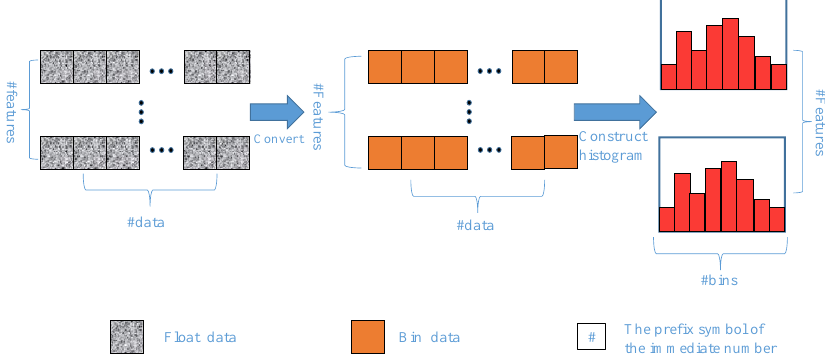
Figure 8. Sort structure based on histogram optimization.